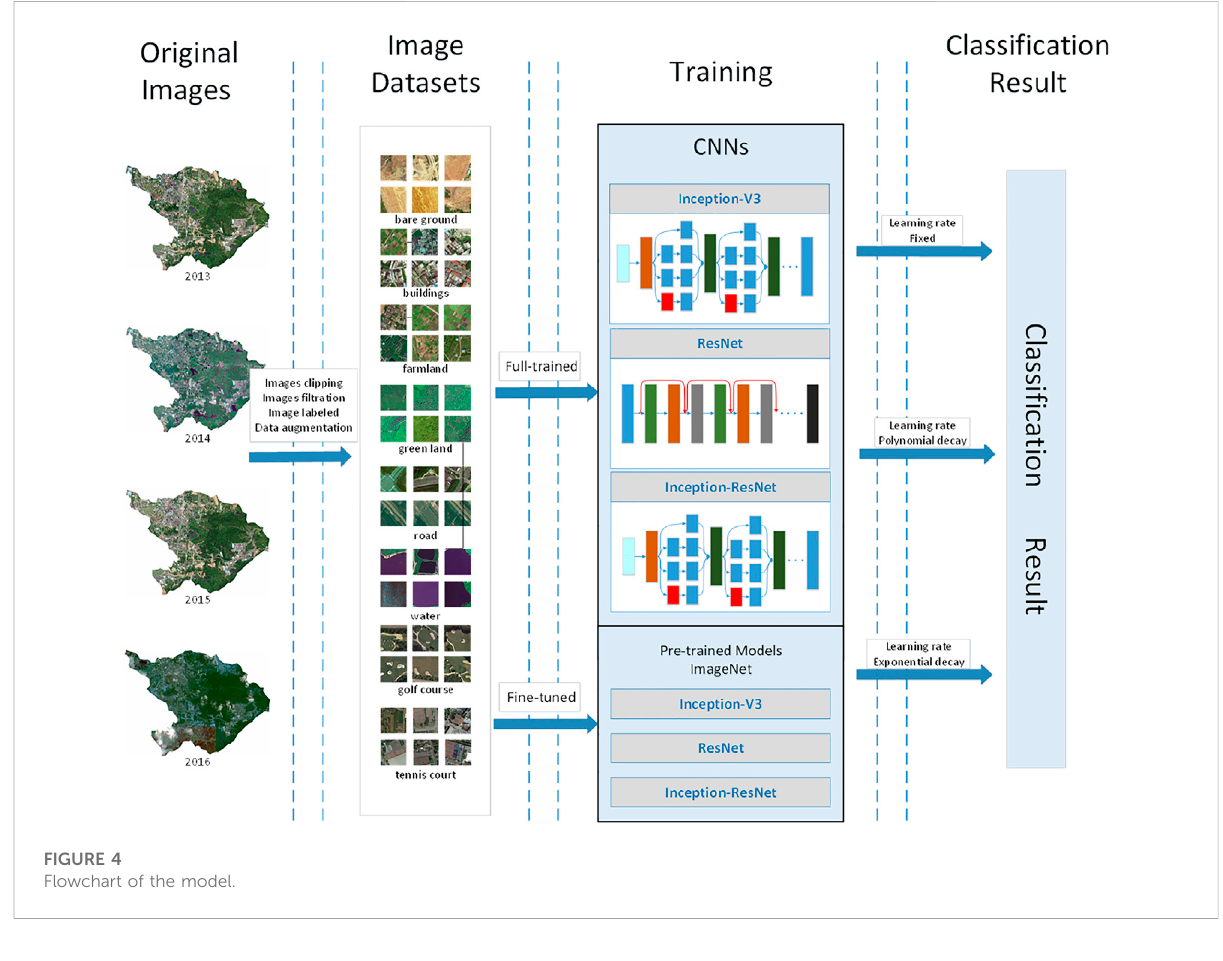
FIGURE 4 Flowchart of the model.